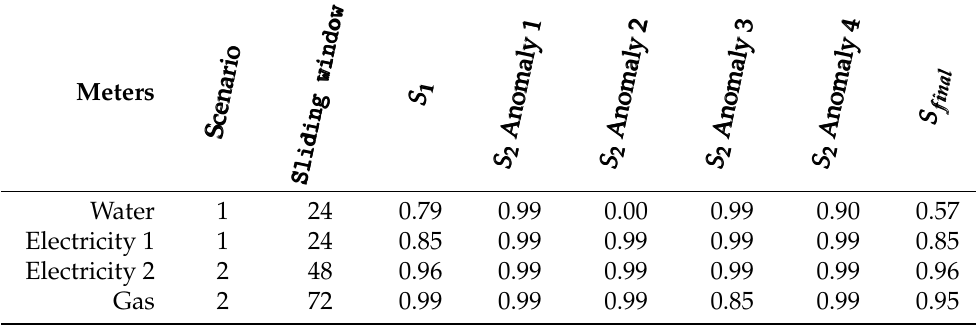
Table 6. Best results for each meter with the VAE algorithm, according to the proposed metric, among all scenarios and considering the mentioned